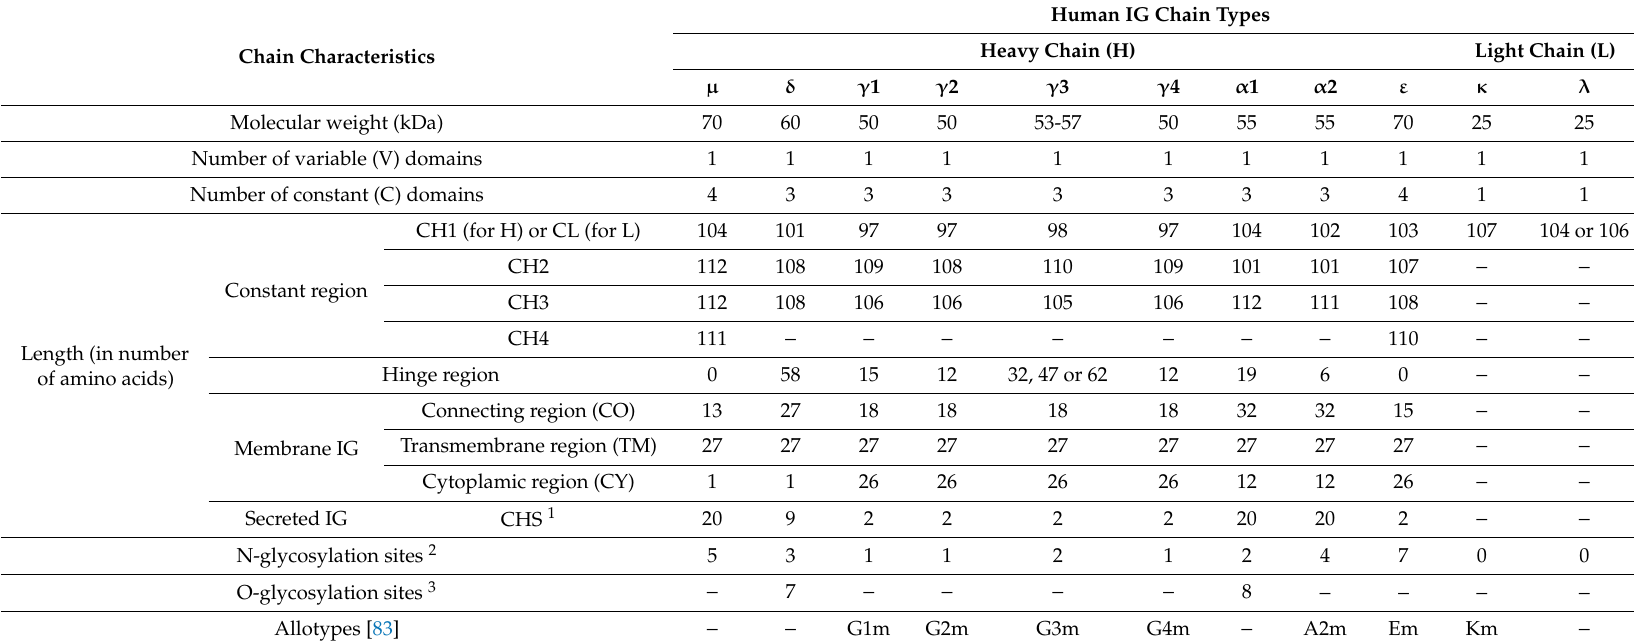
Table 3. Homo sapiens immunoglobulin (IG) chain characteristics